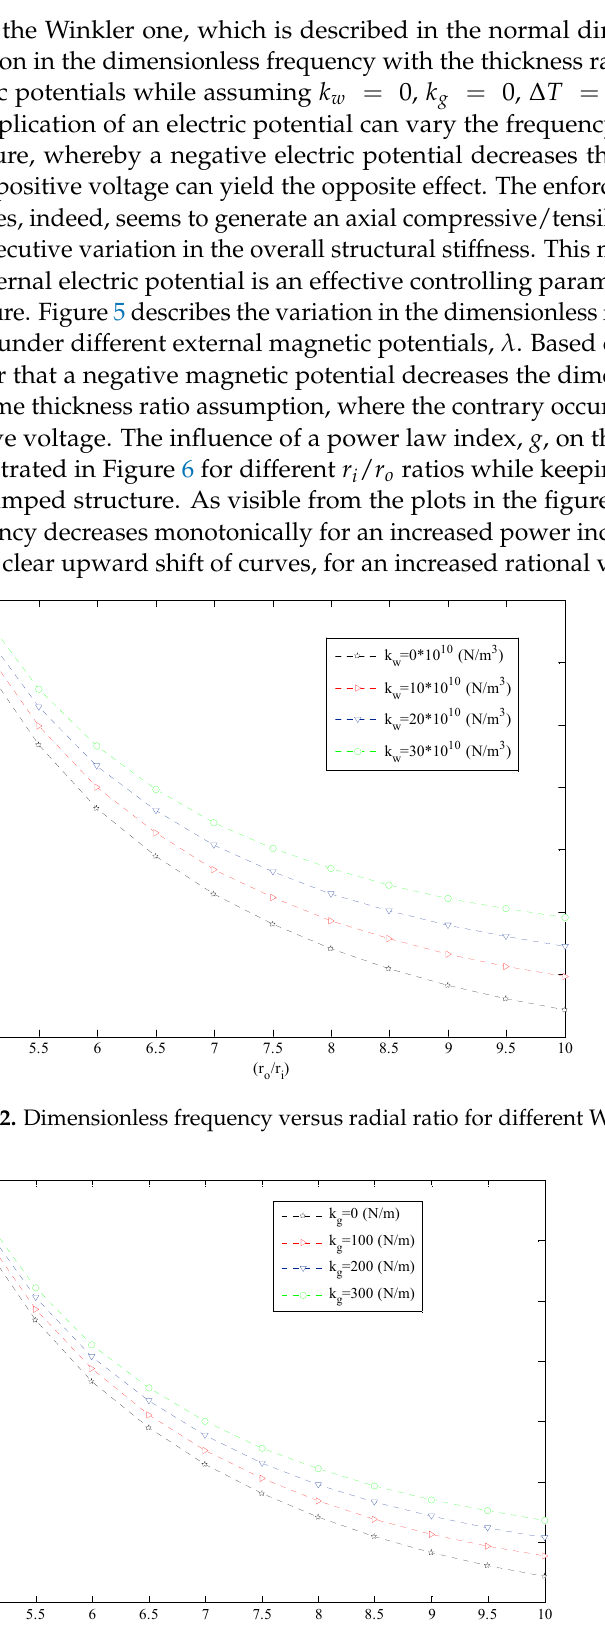
Figure 4. Dimensionless frequency versus thickness ratio for different variations in external electric potential.